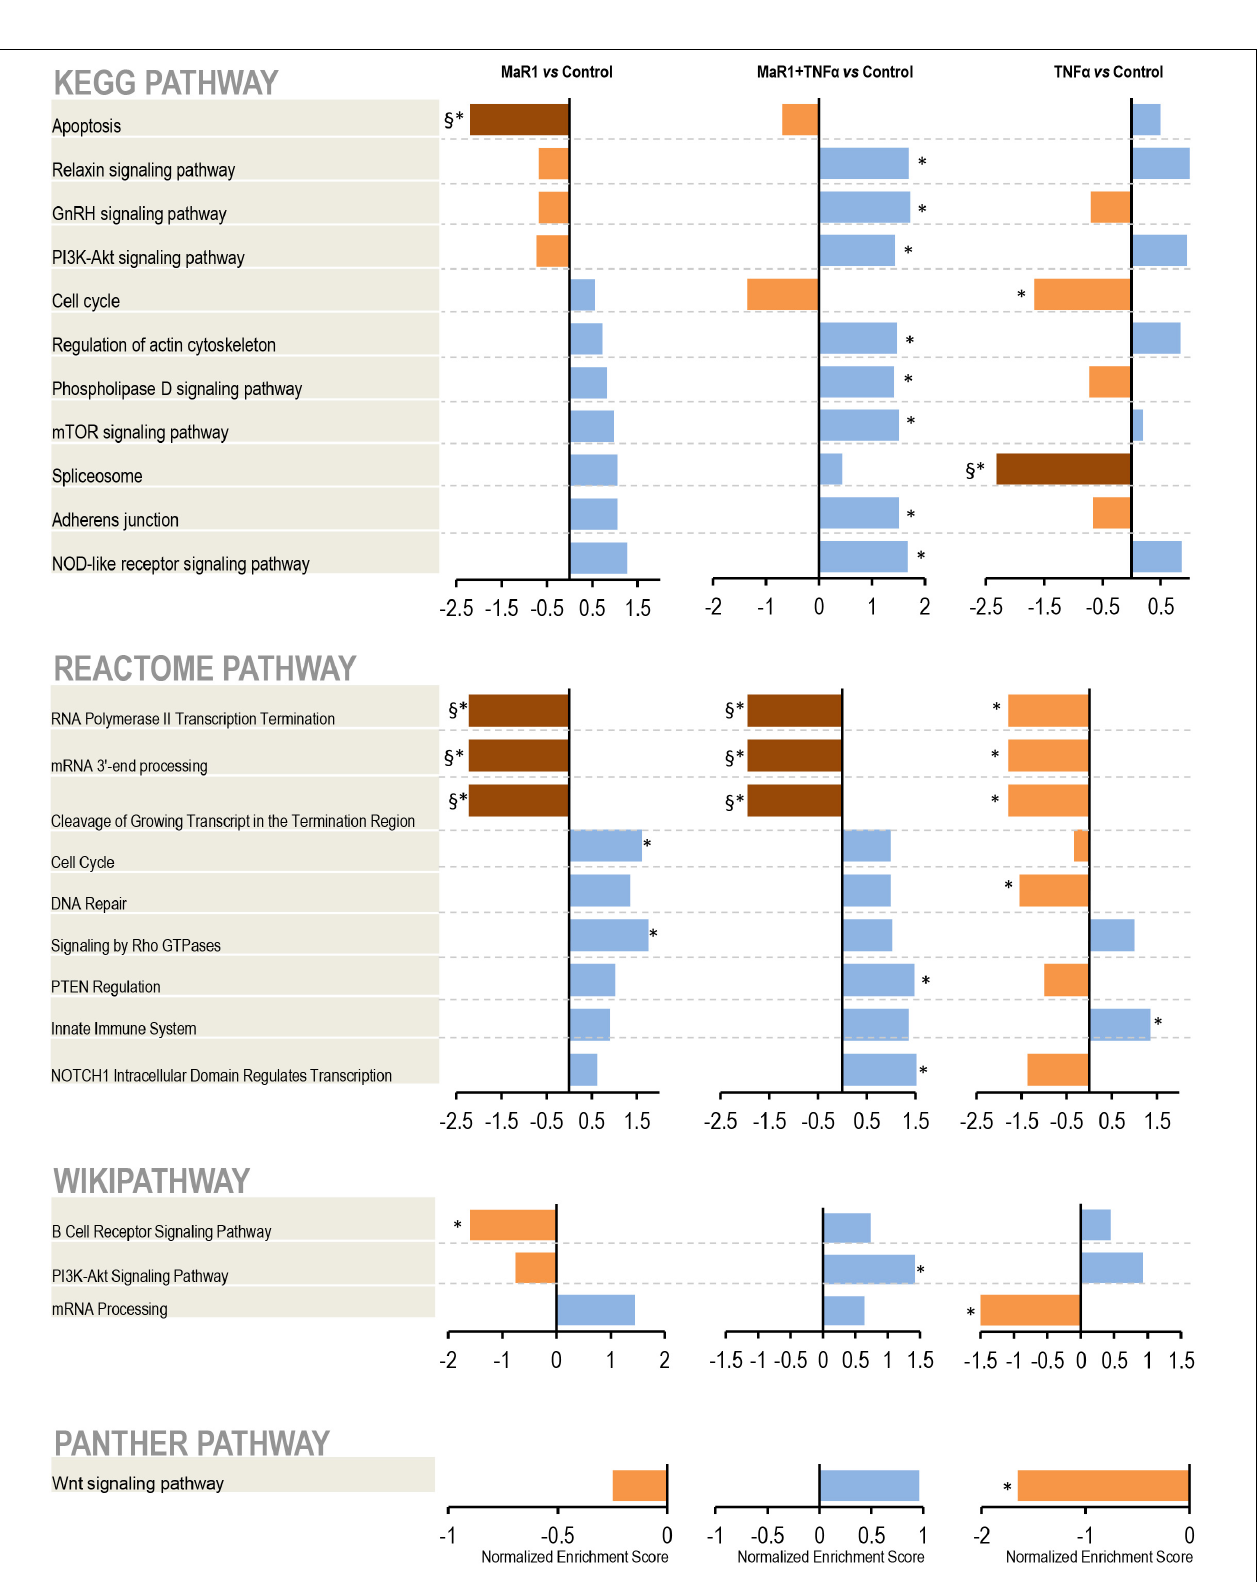
FIGURE 6 | Pathway analysis. After identification, the protein accession list was scored and ranked by adjusted p -values to be analyzed using the WEB-based GEne SeT AnaLysis Toolkit and the Gene Set Enrichment Analysis (GSEA) method. The pathways identification was performed using different functional databases: KEGG, Reactome, PANTHER, and Wikipathway. (*) Significant difference using t -test; (§) Significant difference after adjustment by Bonferroni post-hoc test.